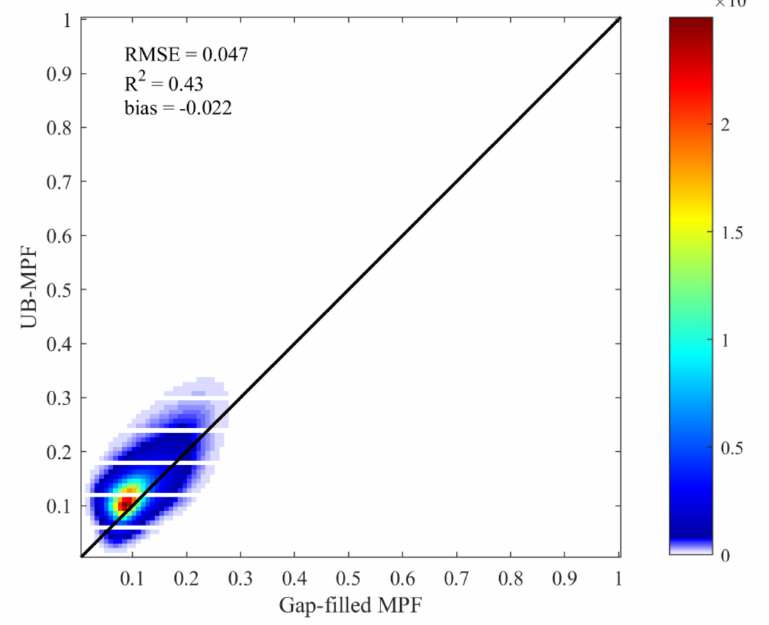
Figure 12. Comparison of gap-filled MPF with the UB-MPF dataset. The color gradient represents the density of the scatter in each